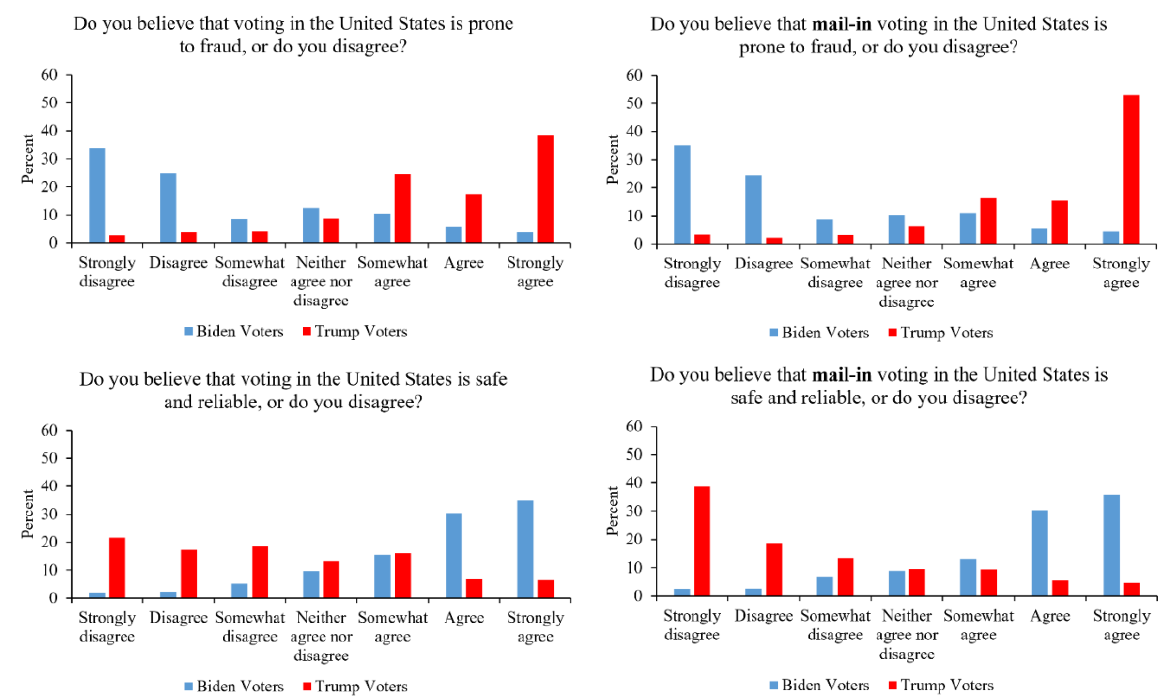
Figure 1. Belief in voter fraud . Percent of Biden (blue) versus Trump (red) voters who believe that voting (left panel) and specifically mail-in voting (right panel) is prone to fraud (top panel) or safe/reliable (bottom